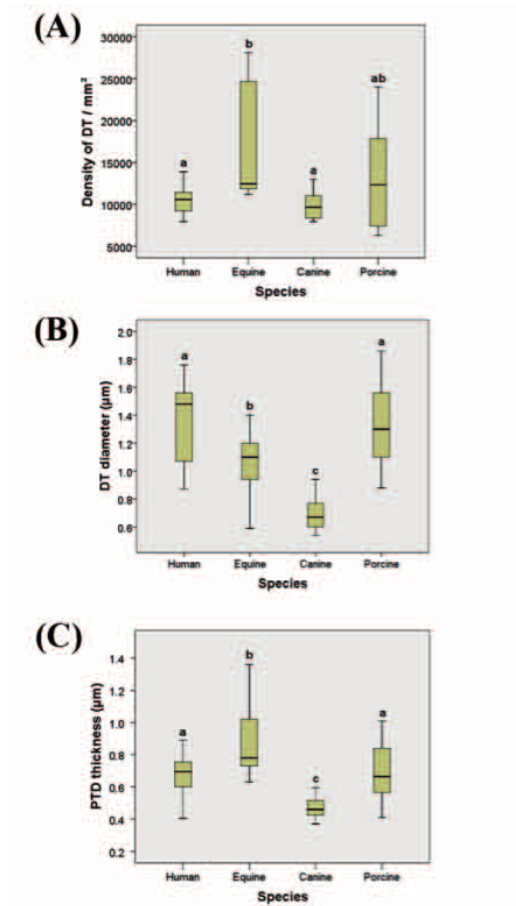
Figure 3. Box plots show median, upper and lower quartiles and the range of results of (A) density of DT per square plane, (B) DT diameter, and (C) PTD thickness of human, equine, canine and porcine dentin samples. Boxes marked with the different letters are signifi cantly different (P < 0.05).